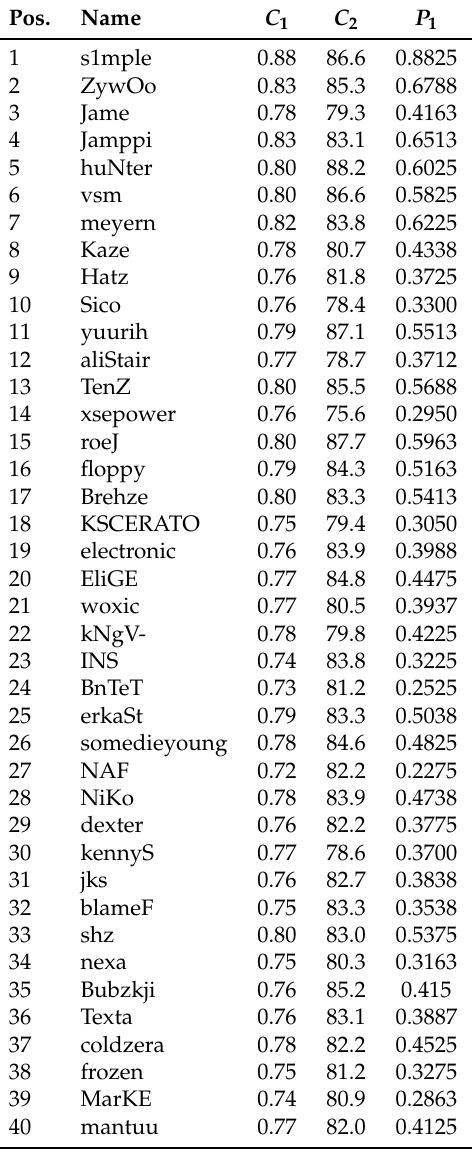
Table 12. The performance table of the selected criteria C 1 , C 2 and assessment model P 1